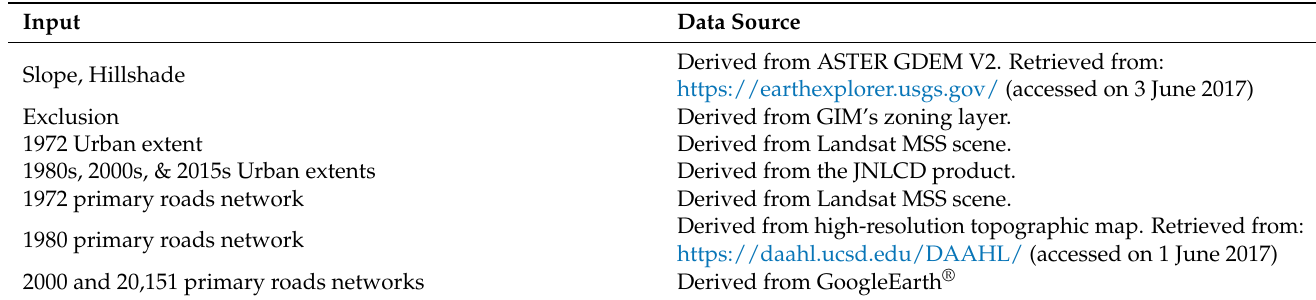
Table 3. SLEUTH inputs and variables.